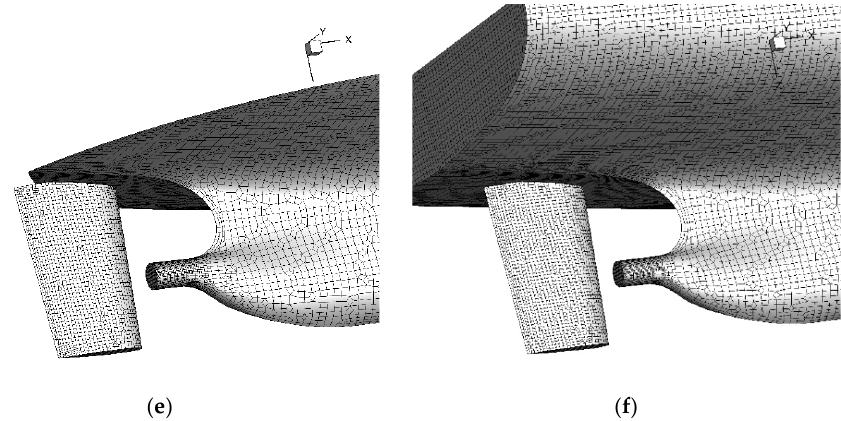
Figure 2. Grid arrangements for double-body flow simulation (left) and water–air flow simulation (right). ( a , b ): overview. ( c , d ): view of o-xz plane. ( e , f ):part of stern.